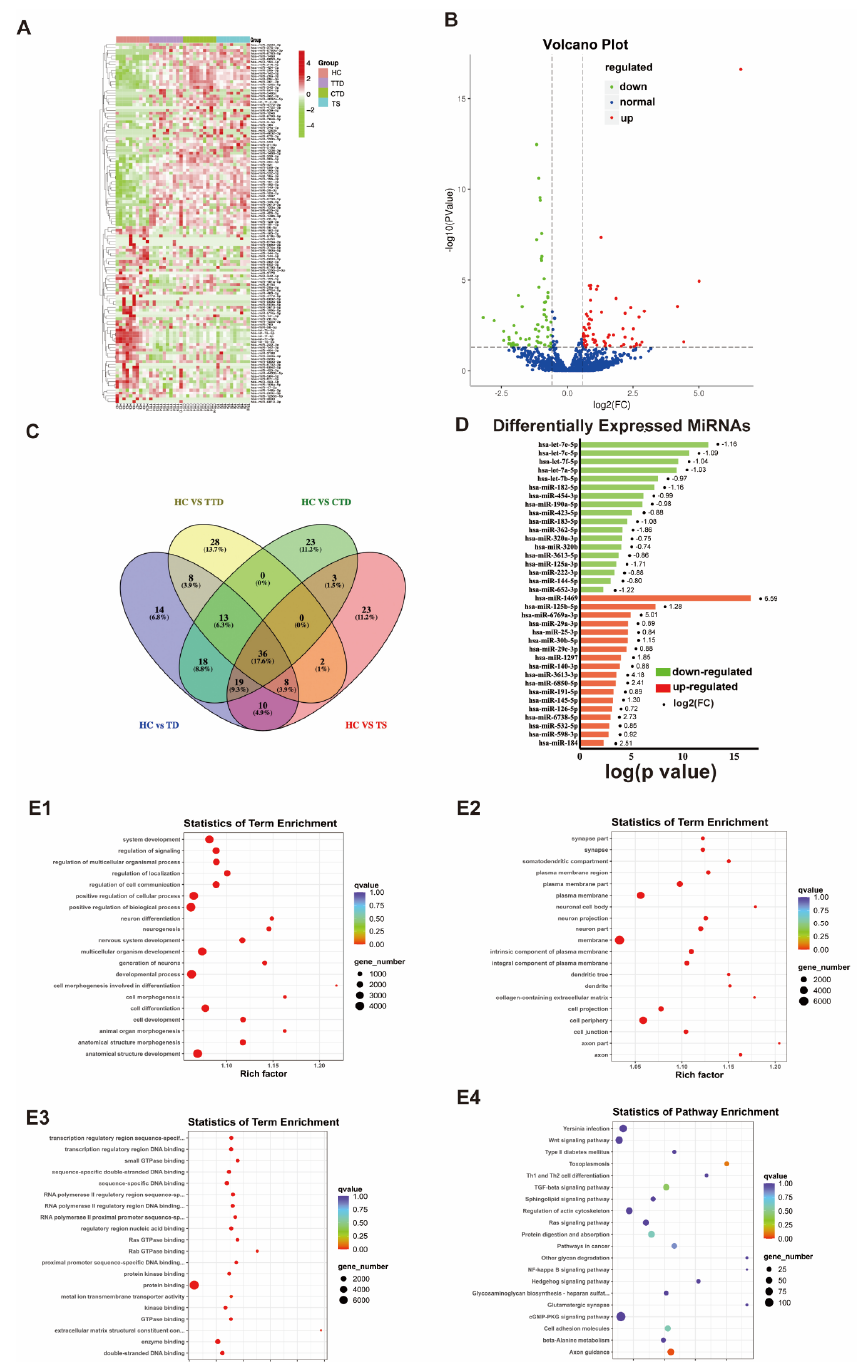
Figure 3. Expression Profile of miRNAs derived from plasma sEVs in tic disorder patients. ( A ) Heat map representing color-coded expression levels of differentially expressed miRNAs (DEMs),